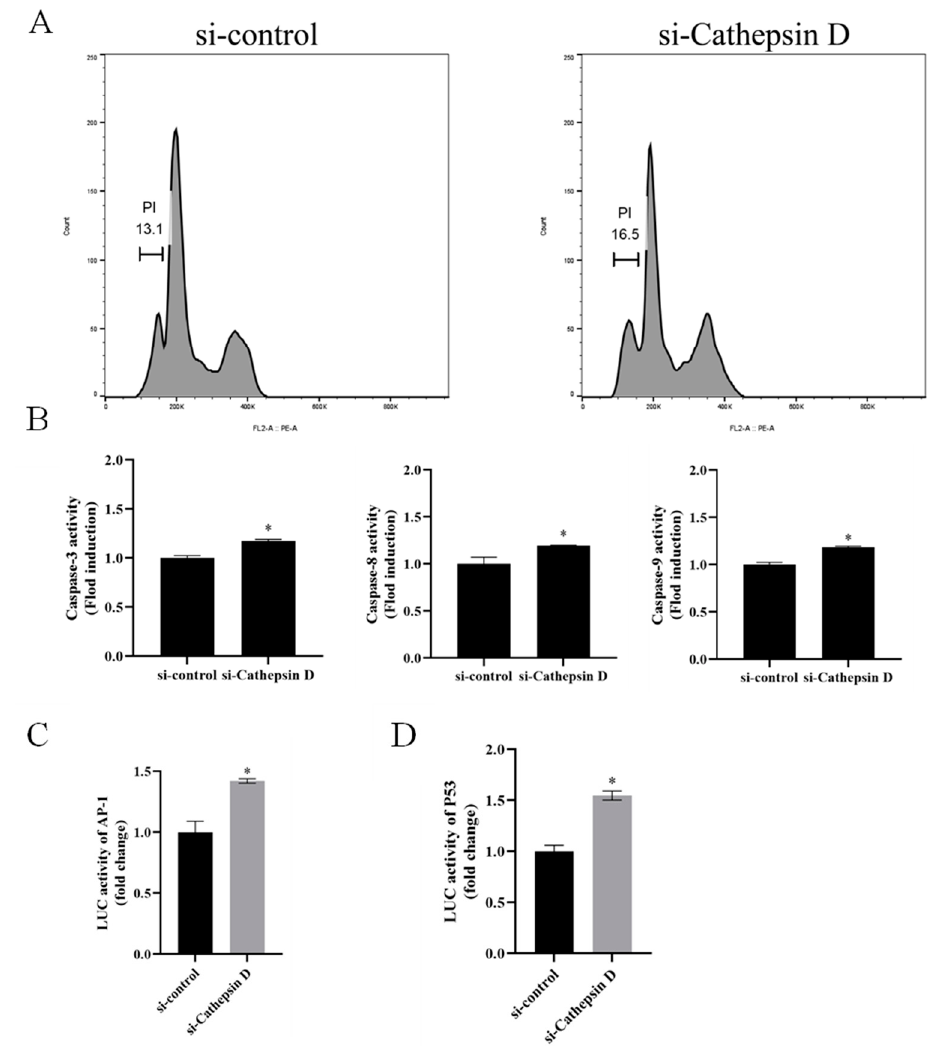
Figure 6. Knockdown of Ec-CD promoted apoptosis. FHM cells were infected with SGIV after being transfected with si-control or si-Cathepsin D. ( A ) The percentage of apoptotic cells in the hypodiploid DNA peak (sub-G1 population) was calculated by sub-G1 population/total cell cycle populations. ( B ) The activity of caspase-3, caspase-8 and caspase-9 after SGIV infection. ( C , D ) FHM cells were co-transfected with AP-1-Luc or P53-Luc and si-Cathepsin D, and then cells were infected with SGIV at 24 h post-transfection. The luciferase reporter gene assay was used to detect the activities of the AP-1 or P53 promoters. Control group: cells were co-transfected with AP-1-Luc or P53-Luc and si-control. Data are means ± SD from four experiments. Student’s t -test: * p < 0.05.